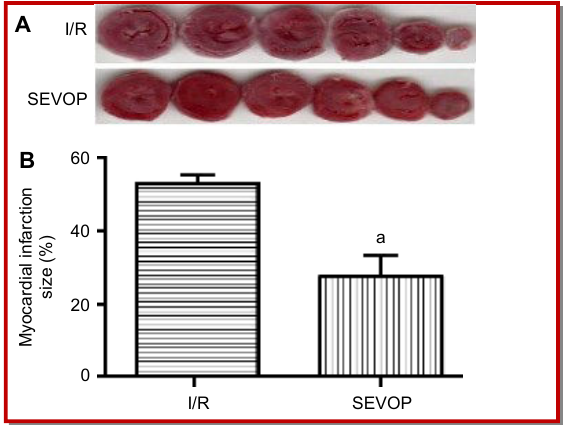
Figure 4: Comparison of myocardial infarction ranges after 2 hours of reperfusion between the two groups Myocardial I/R caused myocardial infarction. Sevoflurane postcondi- tioning reduced the infarction range. (A) Comparison between the I/R and SEVOP groups. After TTC staining, the results were analyzed using the Alpha View gel image analytical software. (B) The difference compared with the I/R group was significant ( a p<0.05). I/R: Myocardi- al ischemia-reperfusion group; SEVOP: Sevoflurane